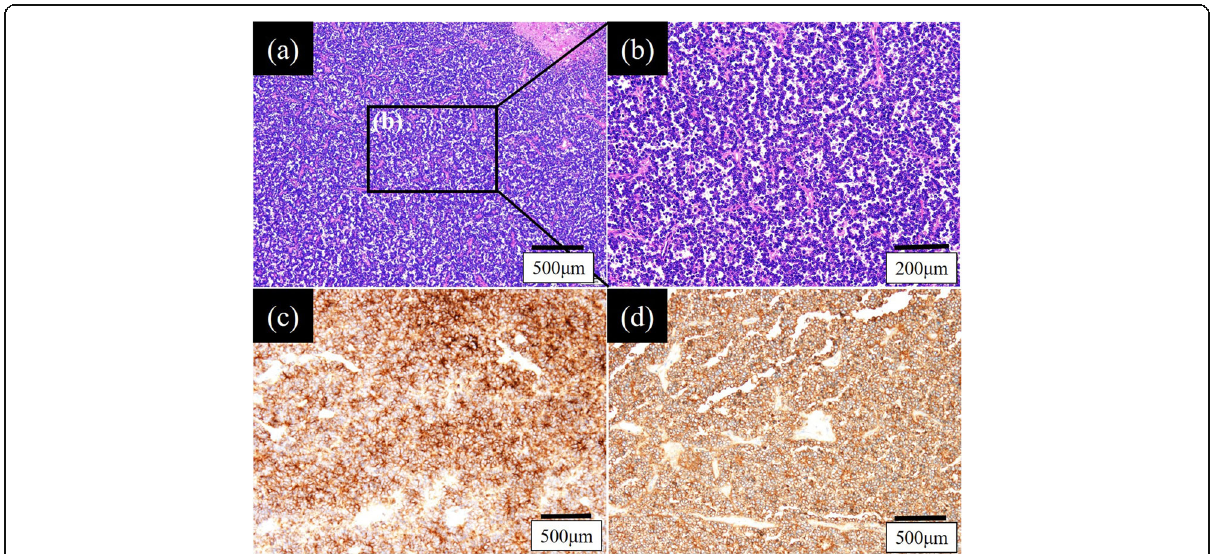
Fig. 3 Hematoxylin and eosin staining revealed that atypical small cells with oval nuclei had multiplied into a micropapillary form with a partially rosette formation ( a , b ). These cells were positive for CD56 ( c ) and CD99 ( d